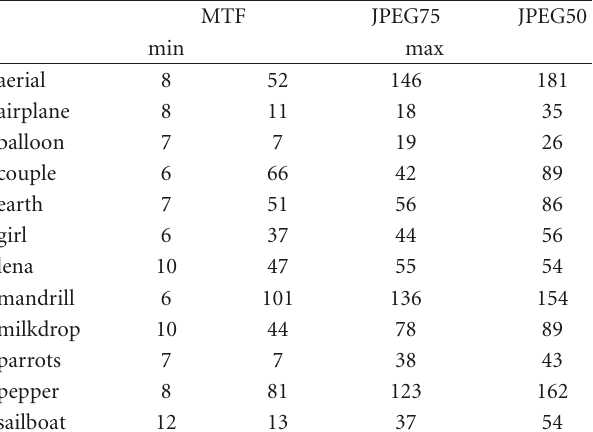
Table 3: The minimum and maximum of Q